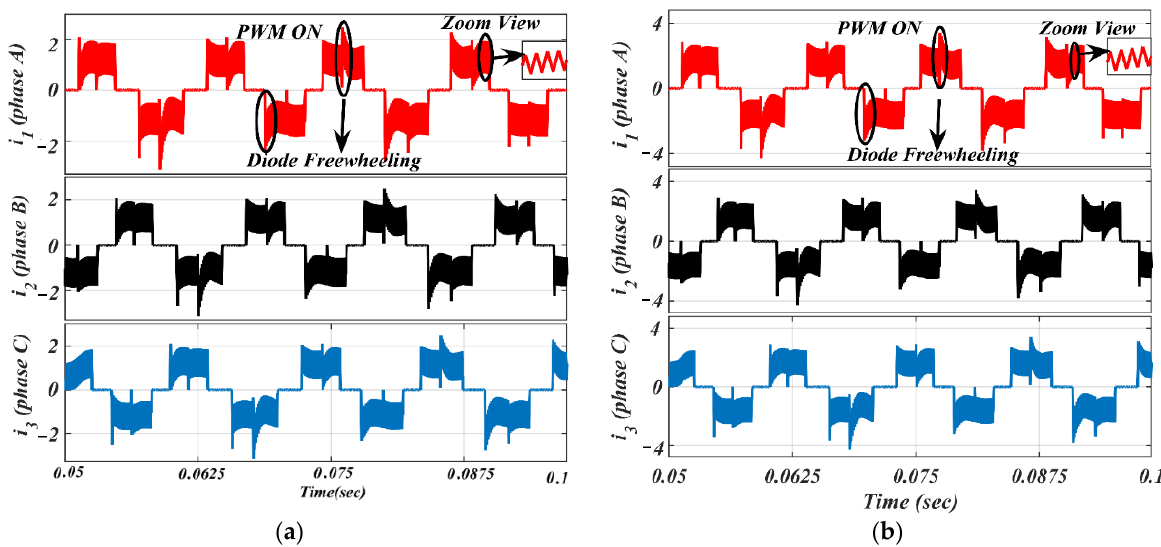
Figure 13. Simulated waveforms of the phase current based on PWM ‐ ON scheme: ( a ) lightly loaded or partially loaded (40% of maximum load); and ( b ) full load (85% of maximum load).